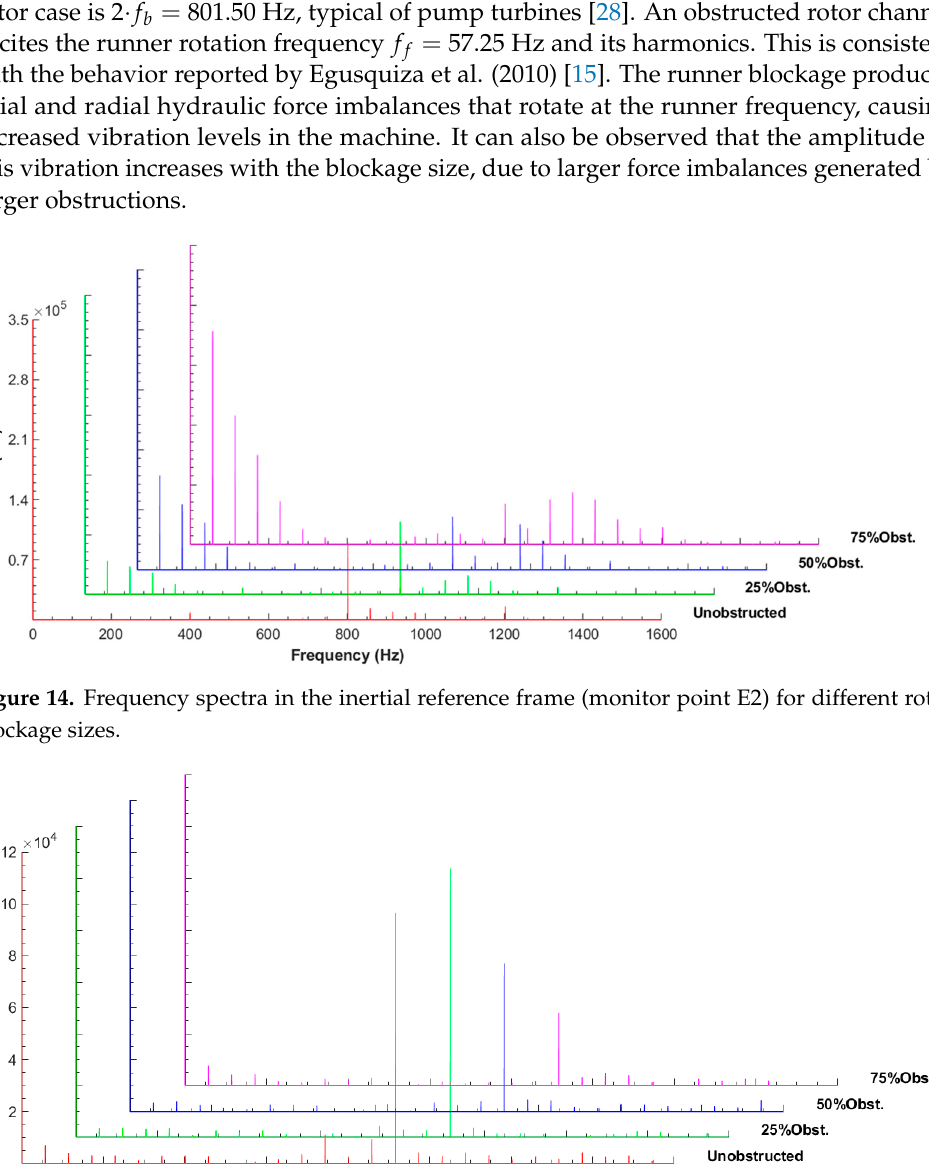
Figure 13. Pressure signal in the rotating reference frame for different rotor blockage sizes.